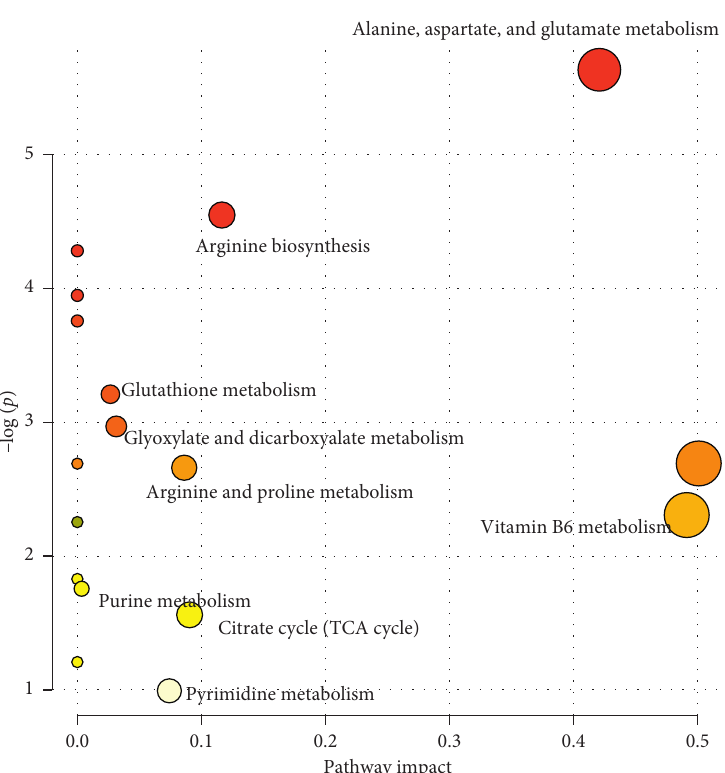
Figure 4: Metabolic pathway analysis showing the main pathways involved in heart failure. The plot shows pathways matched according to the p values in the pathway impact values from the pathway topology